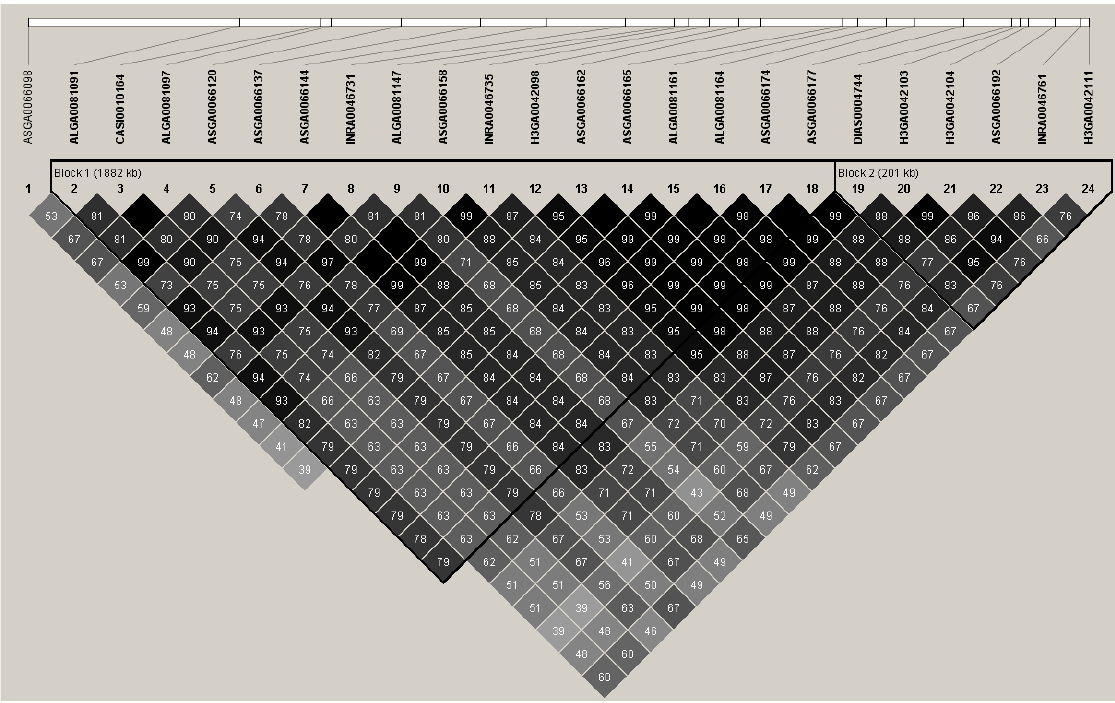
Figure 3. Linkage disequilibrium (r 2 ) diagram of single nucleotide polymorphism (SNP) markers in chromosome 14 associated with fatty acids. The numbers outside the blocks represent SNP order in this region and the numbers inside the blocks indicate linkage disequilibrium (LD) coefficients (r 2 ). The SNP grouped in each triangle box are grouped in one block based on LD information. The red mark indicates the position of stearoyl-CoA desaturase (SCD)